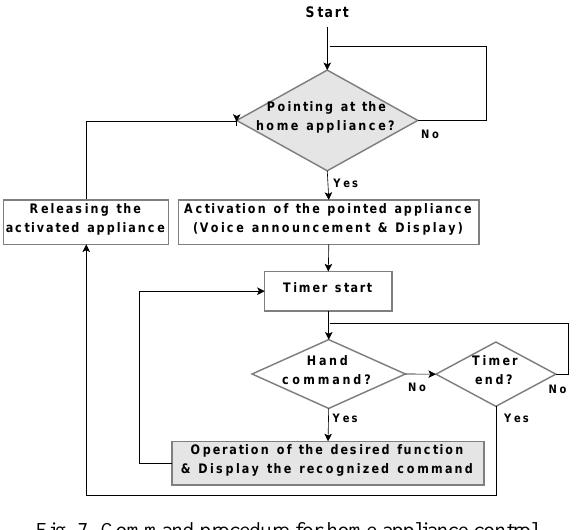
Fig. 7. Command procedure for home appliance control